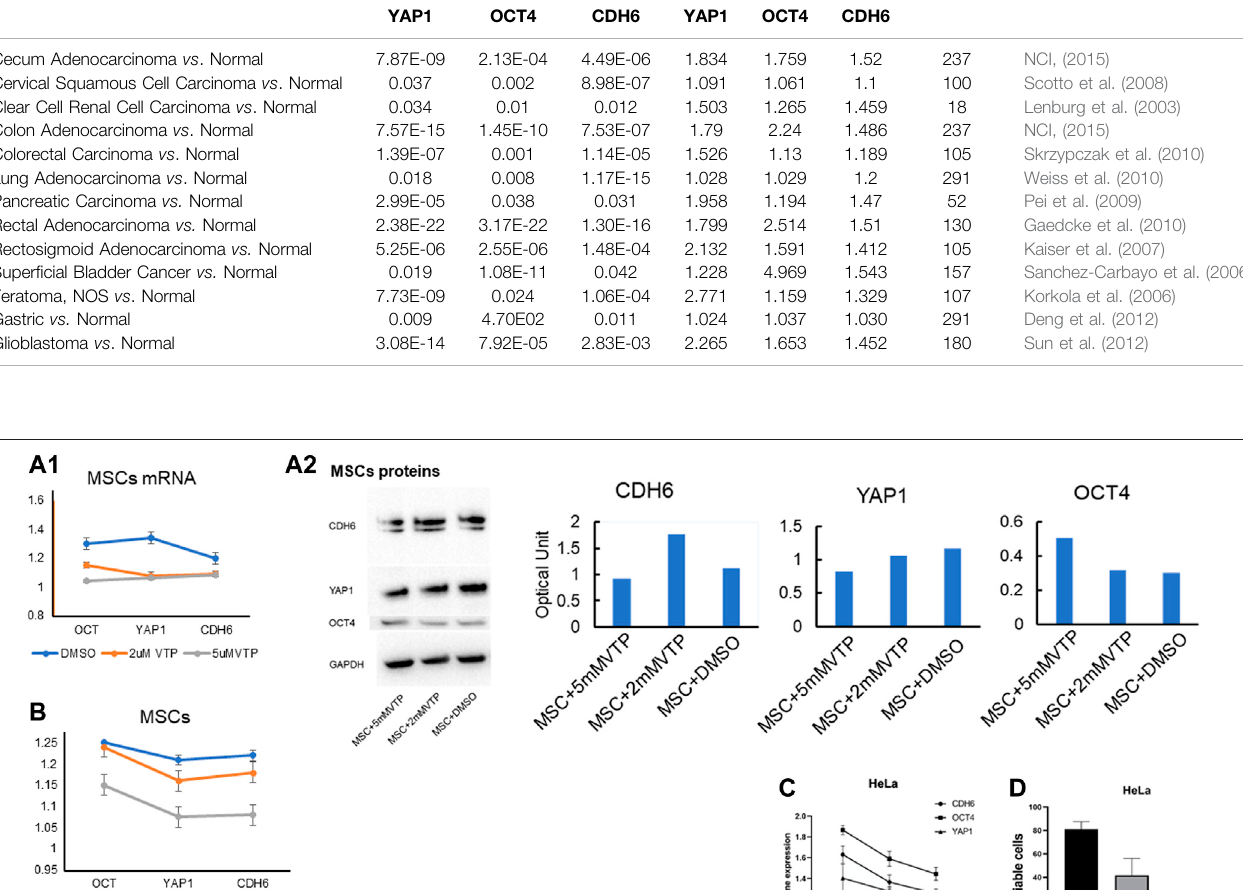
Frontiers in Cell and Developmental Biology |